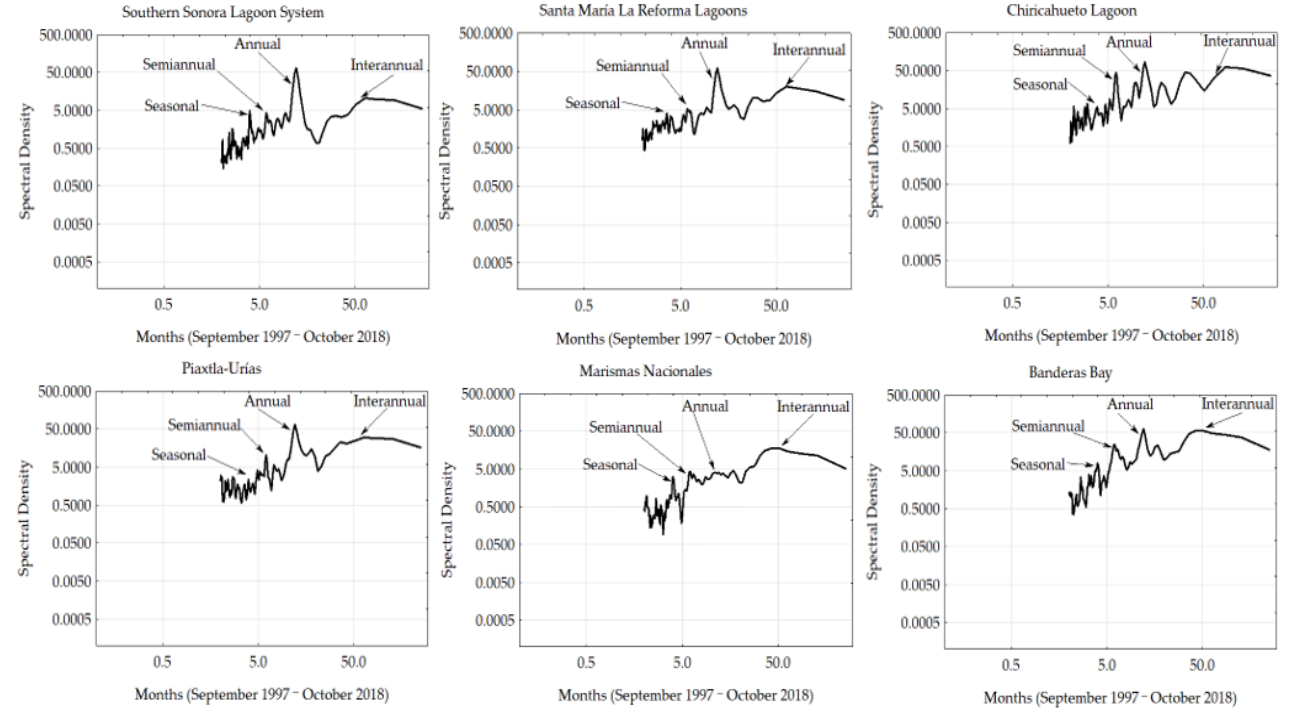
Figure 9. Fourier analyses of Chlorophyll a (Chl a ) concentration for the regions of the northwest of Mexico (Southern Sonora Lagoon System, Santa María La Reforma Lagoons, Chiricahueto Lagoon, Piaxtla-Urías, Marismas Nacionales and Banderas Bay).